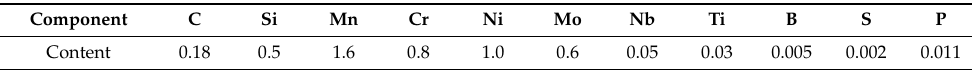
Table 1. Chemical composition of Q960 high strength steel (mass, wt %).